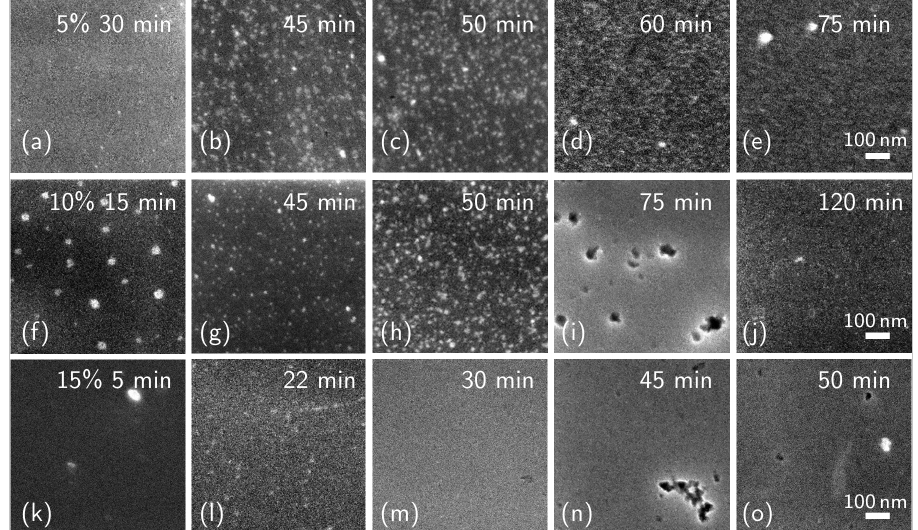
Figure 1. SEM images of the samples at different deposition times. Each row of images refers to samples dip-coated in solutions of different concentrations: ( a – e ) 5%; ( f – j ) 10%; ( k – o ) 15%. The scale bars refer to all the